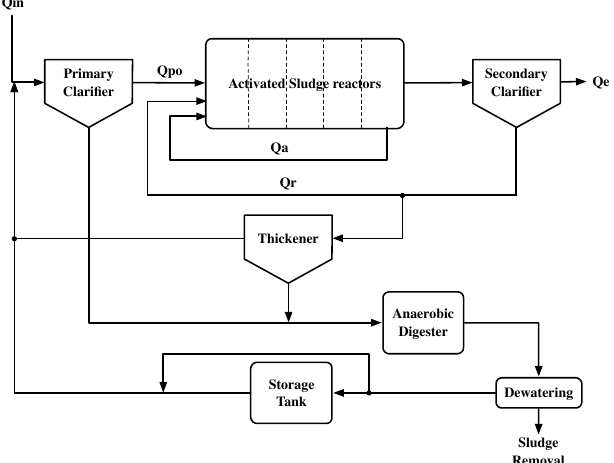
Figure 1. Benchmark Simulation Model N.2 (BSM2) model for a biological wastewater treatment plant